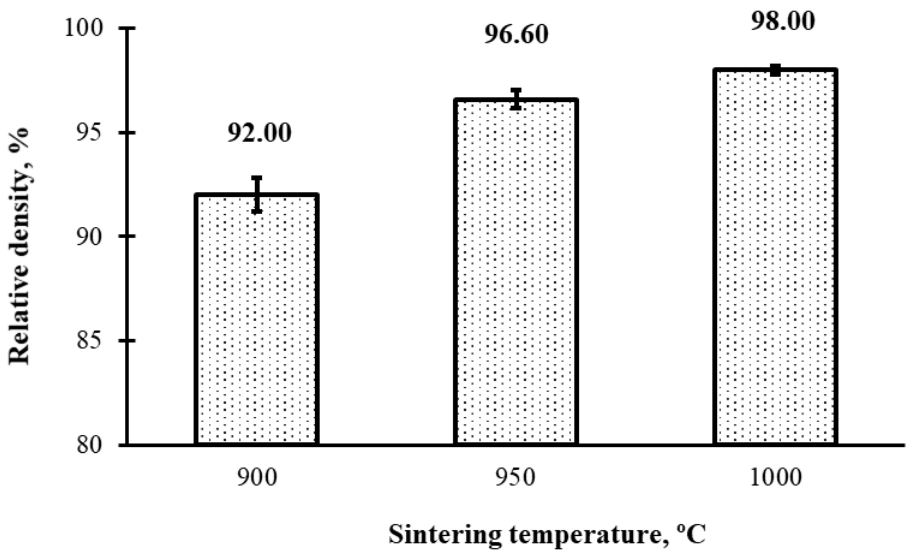
Figure 4. Relative densities of spark plasma sintered M3/2–50% Fe materials.